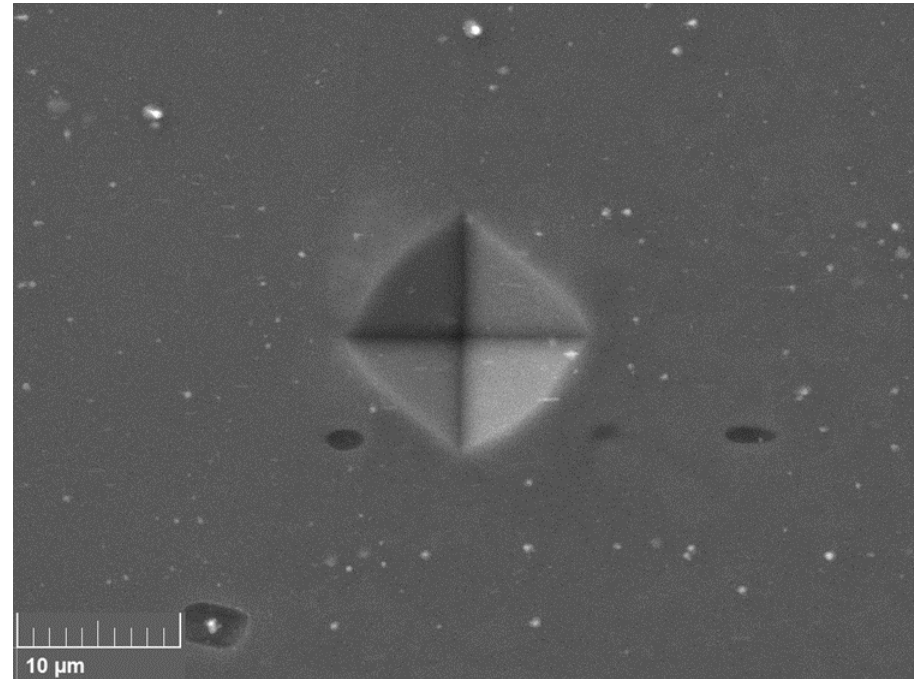
Figure 7. SEM micrograph taken in Secondary Electron (SE) mode of a Vickers microhardness test indentation in the DXZ region adjacent to the embedded tool.